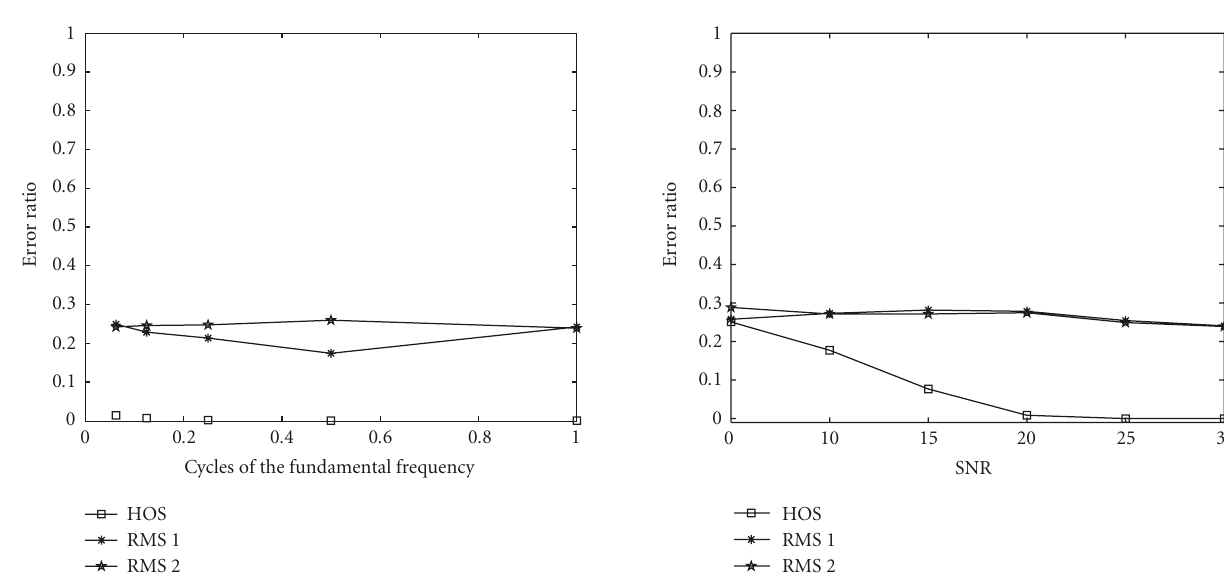
Figure 8: Error detection rate when the frame lengths correspond to 1/16, 1/8, 1/4, 1/2, and 1 cycles of the fundamental component.